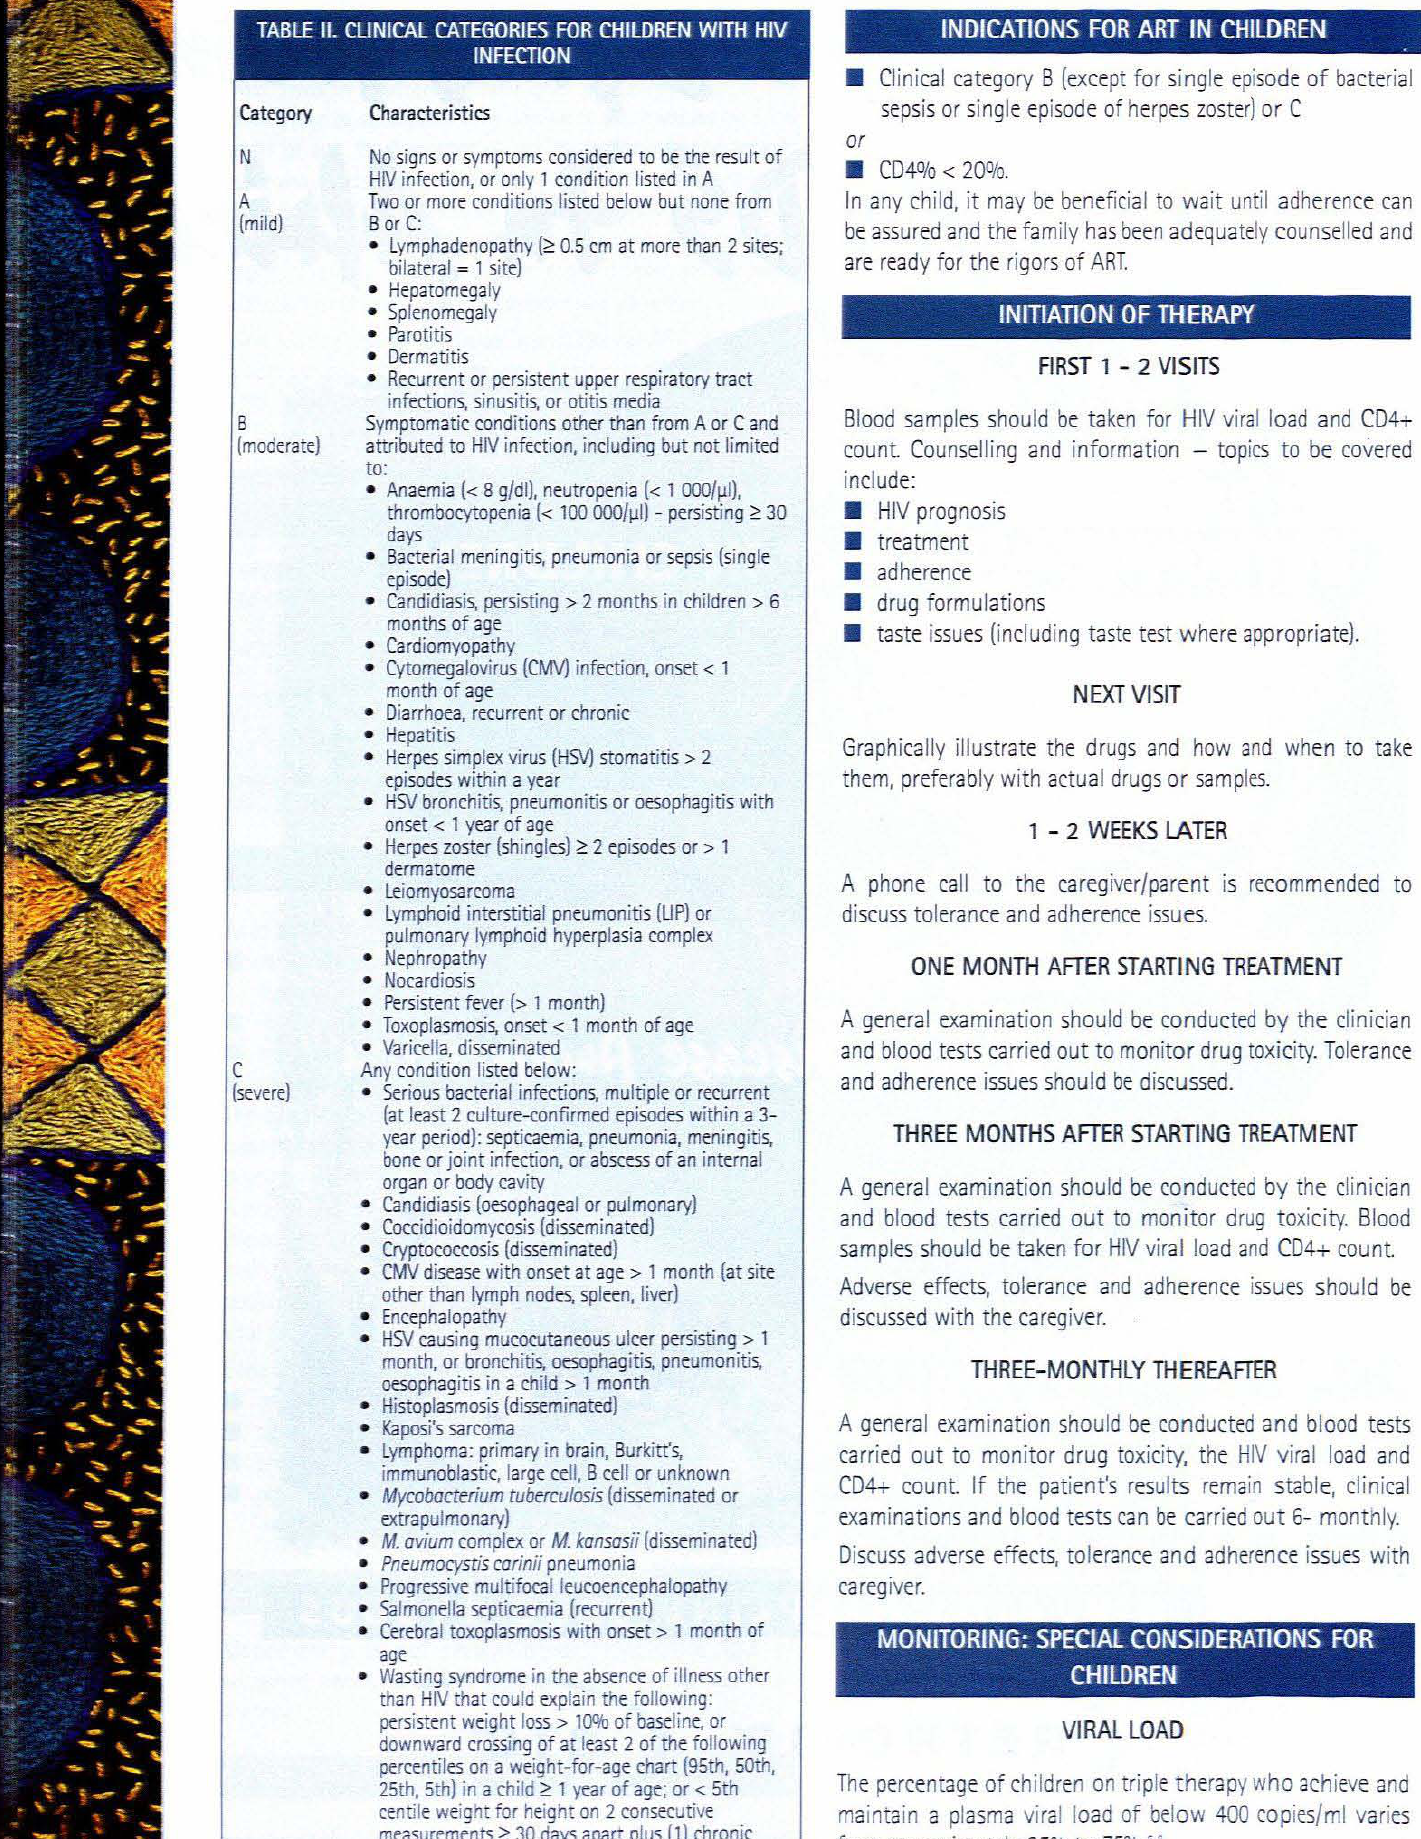
TABLE 11. CUNICAl CATEGORIES FOR CHILDREN WITH HIV